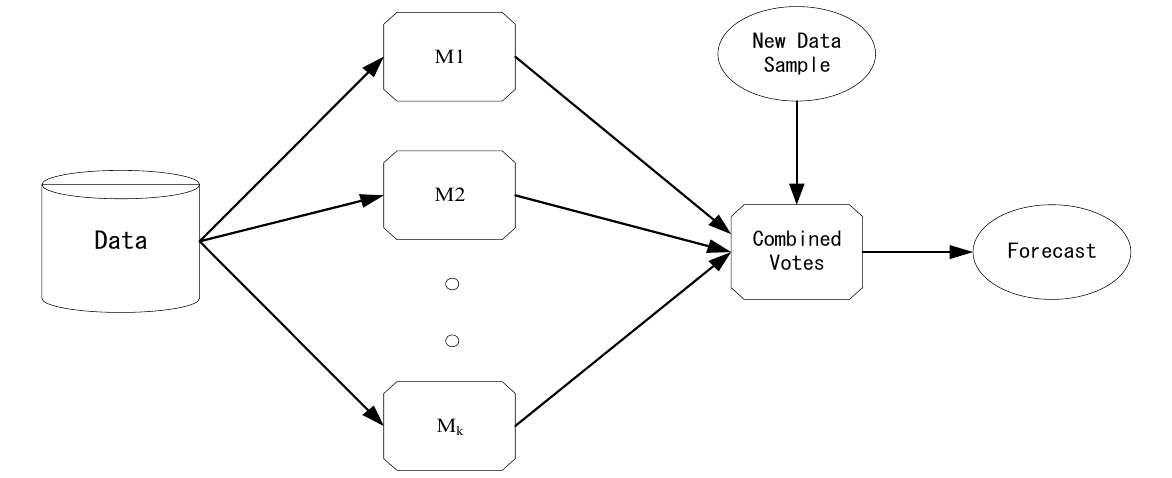
Figure 6. Increased model accuracy methodology.